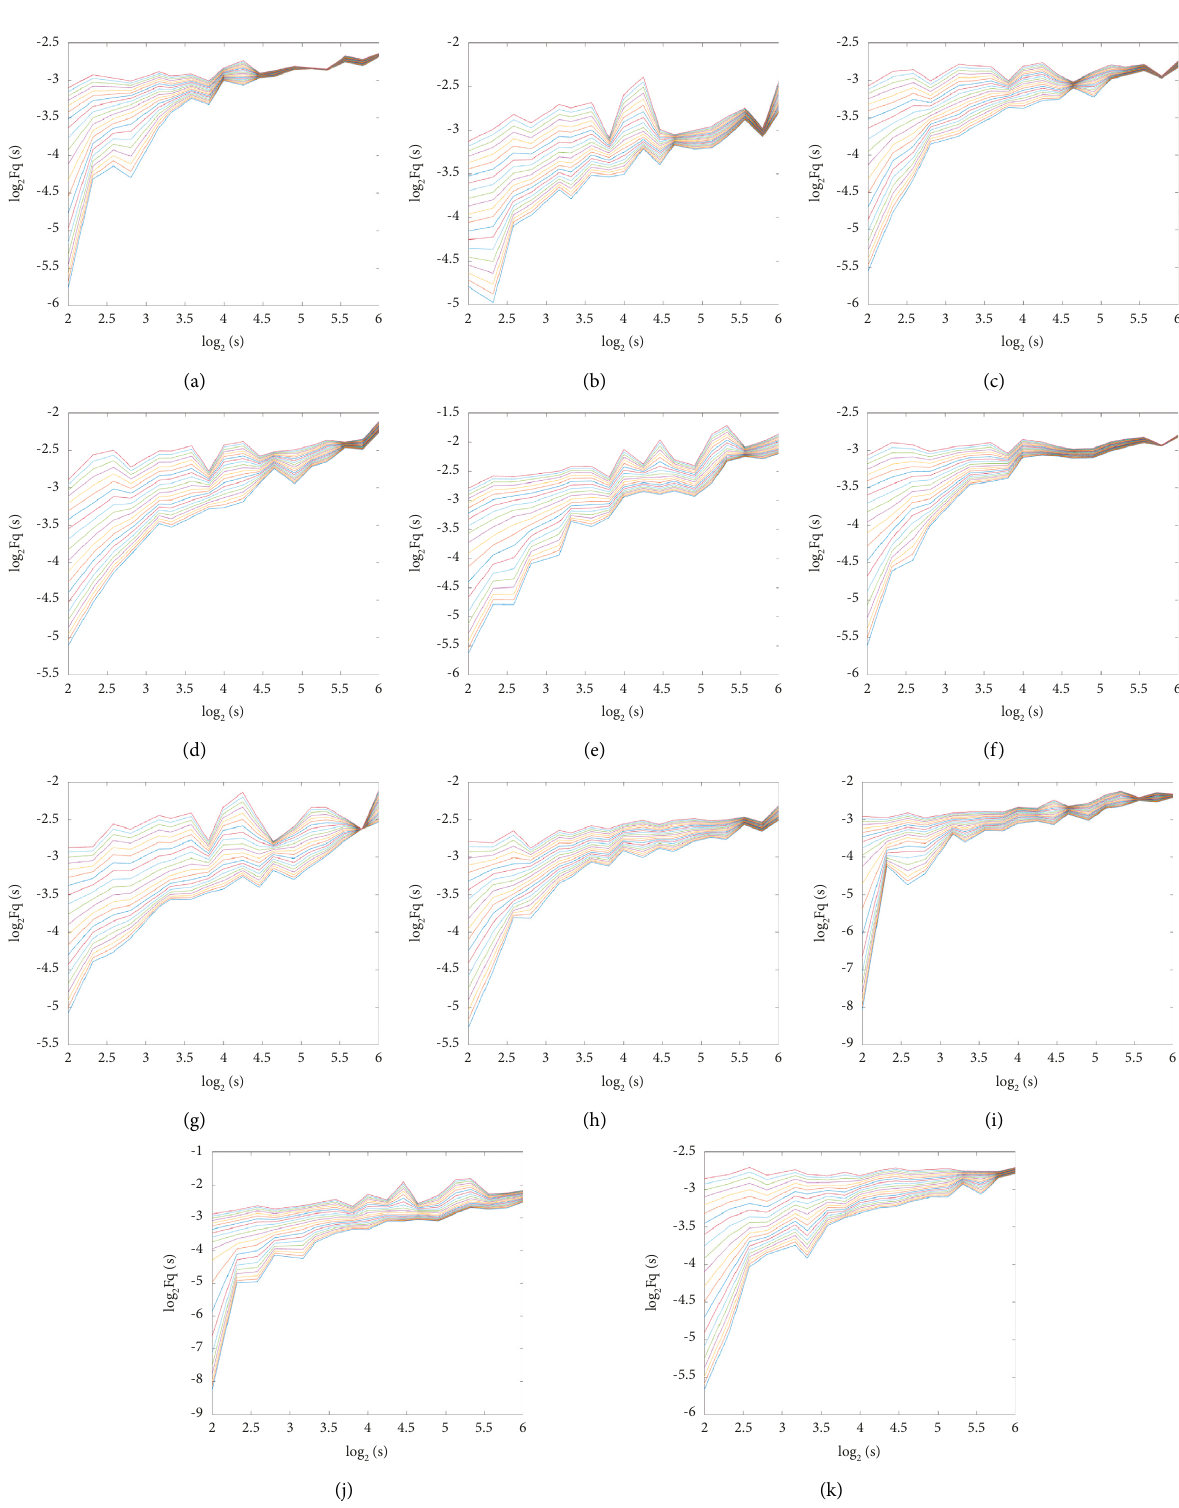
Figure 7: The curve of the multifractal fluctuation function Fq ( s ) compared to s in a log-log plot of the MATV series for all the sectors during the GFC. (a) Communication service. (b) Consumer discretionary. (c) Consumer staples. (d) Energy. (e) Financials. (f) Health care. (g) Industrials. (h) Information technology. (i) Materials. (j) Real estate. (k)